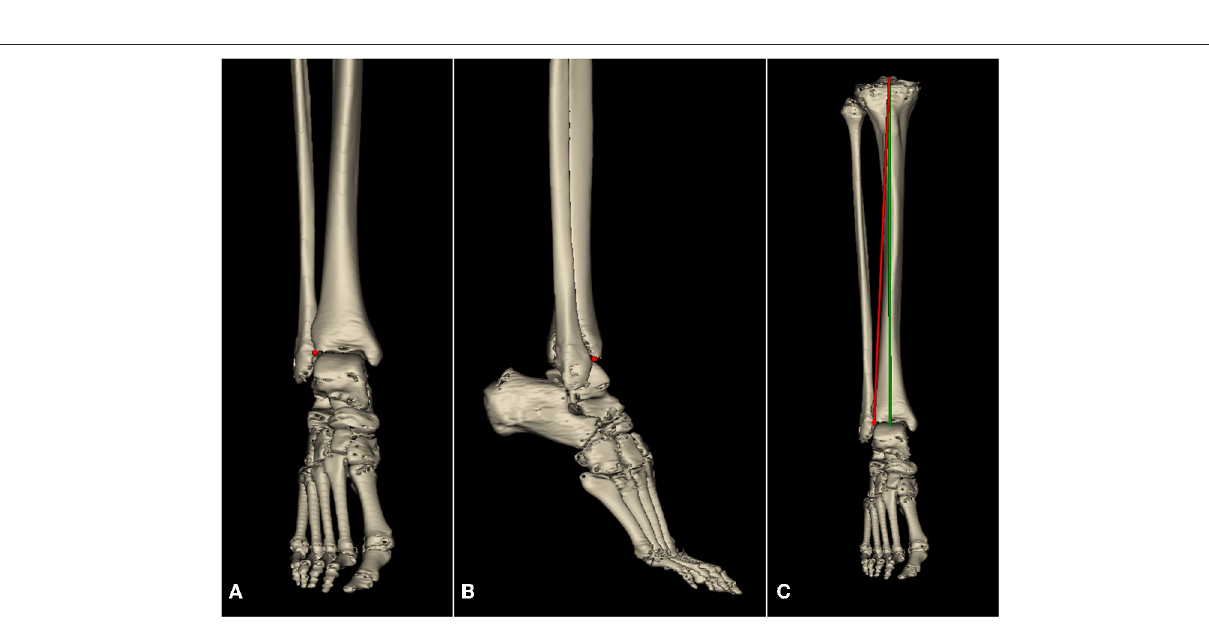
Frontiers in Surgery |